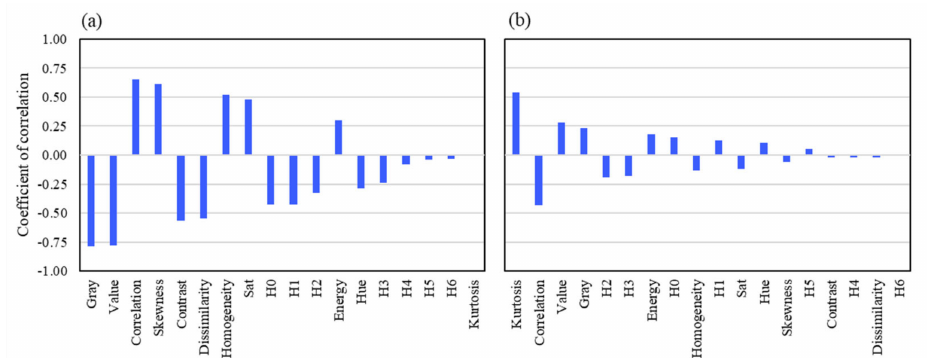
Figure 3. Relationship between soil properties and features from soil surface images: ( a ) coefficient of correlation between water content and features; ( b ) coefficient of correlation between bulk density and